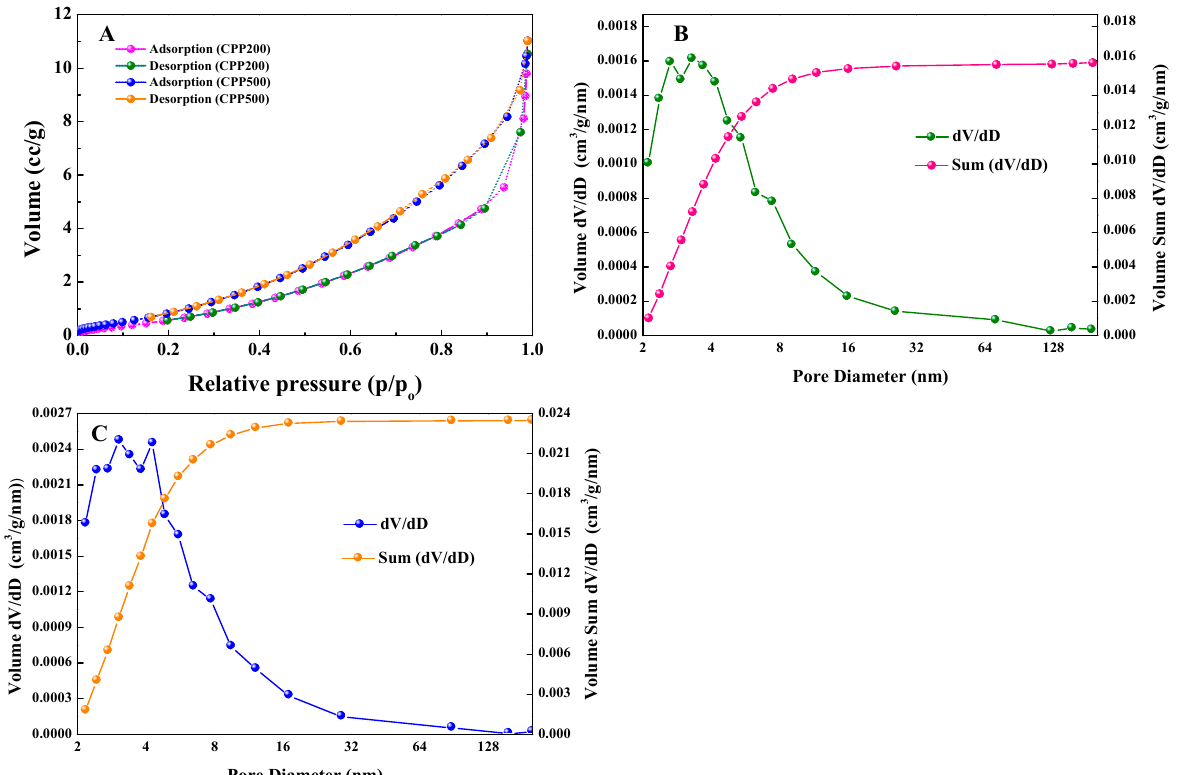
Figure 2. ( A ) N 2 adsorption/desorption isotherms for CPP200 and CPP500; ( B ) BJH pore volume distribution of CPP200; ( C ) BJH pore volume distribution of